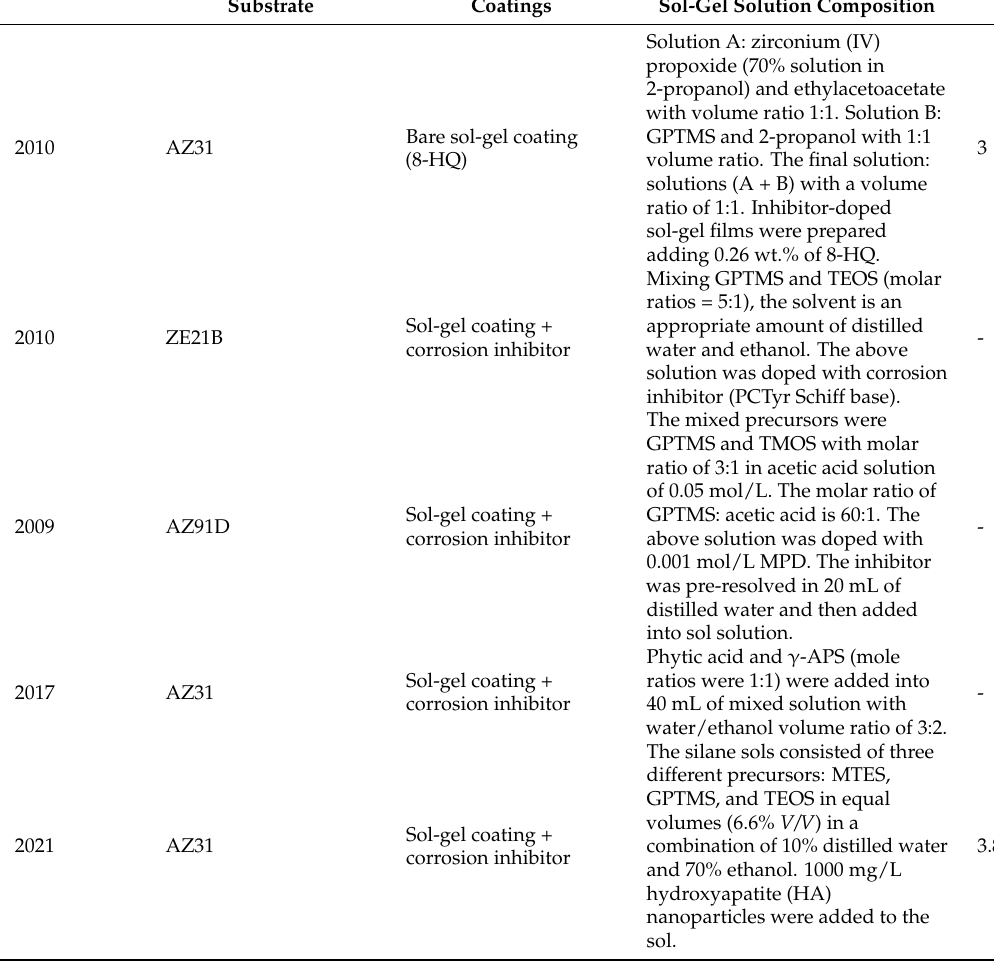
Table 3. Cont. Substrate Coatings Sol-Gel Solution Composition Thickness Electrolyte Anti-Corrosion Effect * Ref. Solution A: zirconium (IV) propoxide (70% solution in 2-propanol) and ethylacetoacetate with volume ratio 1:1. Solution B: GPTMS and 2-propanol with 1:1 Bare sol-gel coating volume ratio. The final solution: (8-HQ) solutions (A + B) with a volume ratio of 1:1. Inhibitor-doped sol-gel films were prepared adding 0.26 wt.% of 8-HQ. Sol-gel coating + corrosion inhibitor